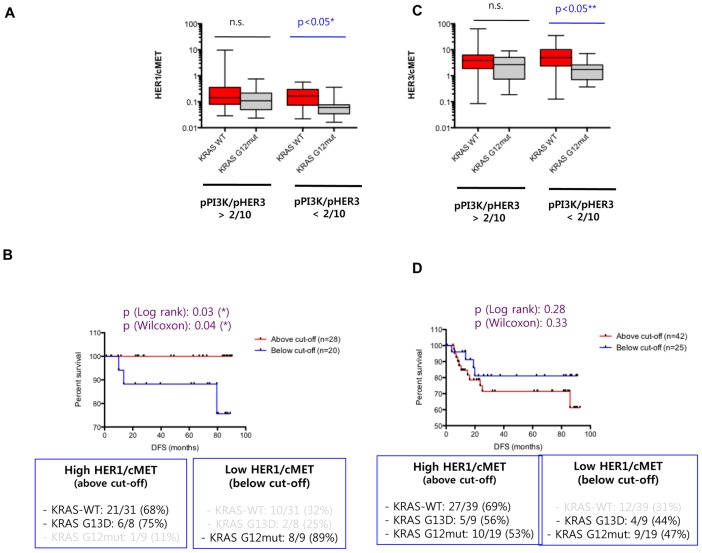
Summary of colorectal cancer (CRC) sub-classifications based on their signaling pathway profiles.Schematic summarizing the sub-classification of CRCs based on their signaling pathway profiles and KRAS mutational status. The possible therapeutic options for each sub-class based on their pathway profiles are indicated.